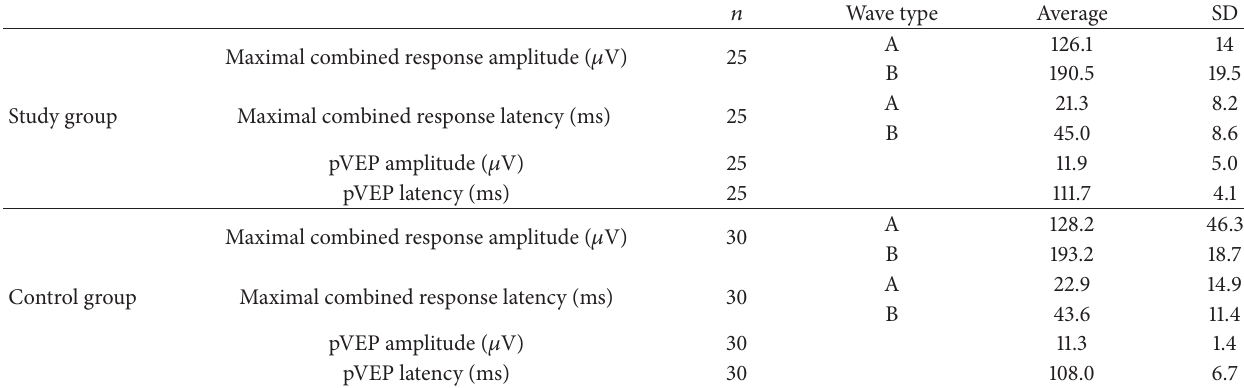
Table 5: Statistical assessment of fERG (maximal combined response) and pVEP measurements of the groups by